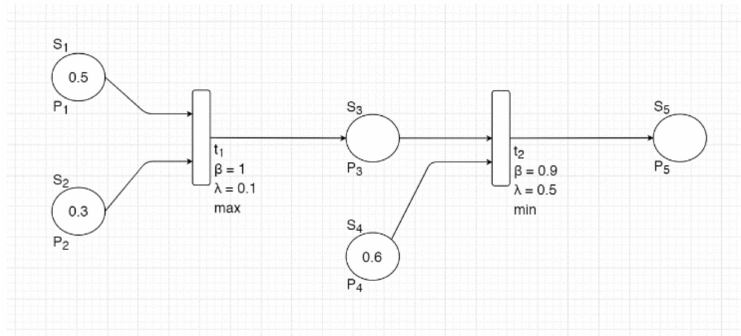
Figure 3. A graphical structure of a fuzzy Petri